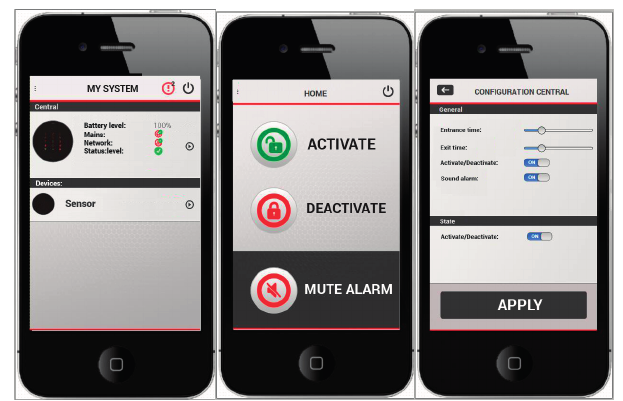
Figure 14. Mobile